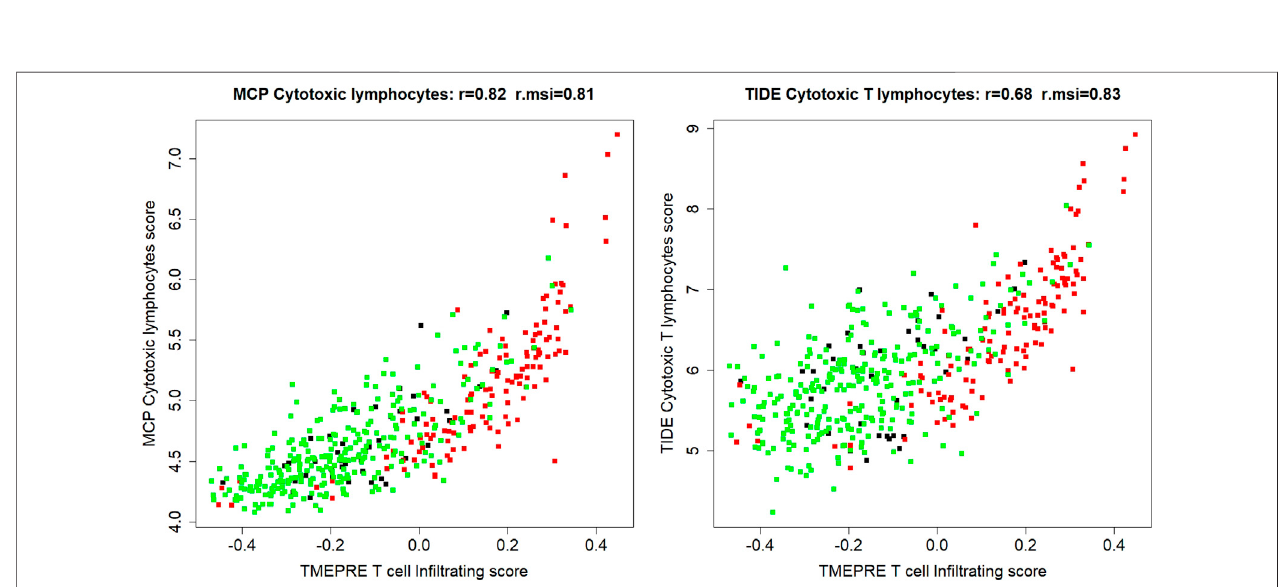
FIGURE 2 | In 454 colorectal cancer samples (MSI (cid:1) 131, MSI-L (cid:1) 23, MSS (cid:1) 284, Unknown (cid:1) 16), the fi rst component of the TMEPRE model , TME 1 . TcellInfiltration score ( x -axis), positively correlates with the counting of MCP-counter cytotoxic lymphocytes score ( y -axis, left panel) and TIDE cytotoxic T lymphocytesscore( y -axis,right panel).MSItumorsareshown inred;MSStumorsareshown ingreen;MSI-LandMSI-unknown tumorsareshown inblack.Therelative range coverage of TME 1 . TcellInfiltration scores of MSS samples ( ω MSS . TME 1 . TcellInfiltration (cid:1) 0.89) is the largest among all three methods.